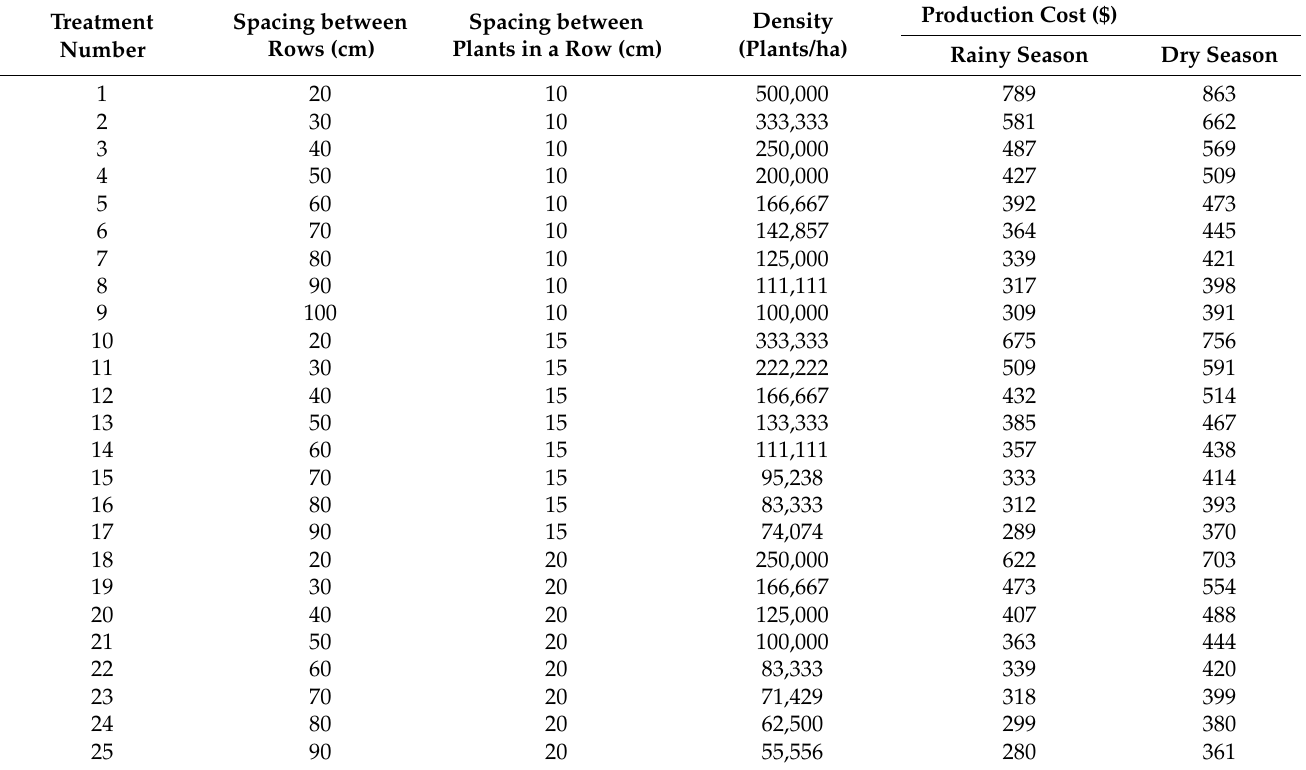
Table 2. Spacing (between rows and plants within a row), and production cost for rainy and dry